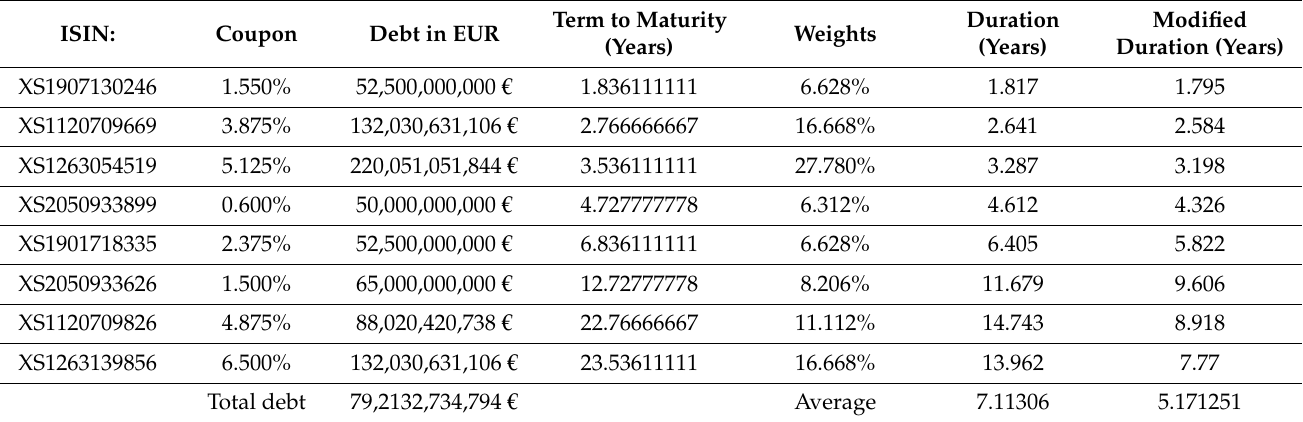
Table 12. Kazakhstan’s Sovereign Bonds